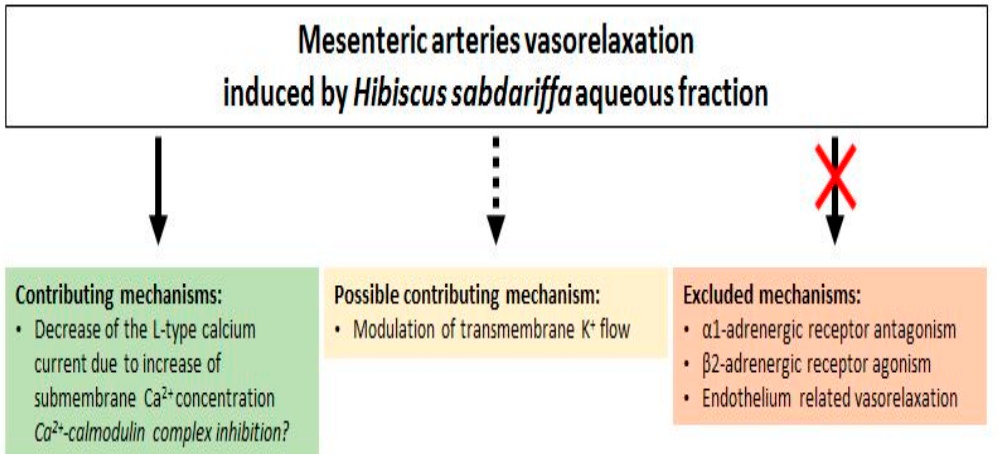
Figure 9. Diagrammatical representation of H. sabdariffa aqueous fraction mediated vasorelaxation in mesenteric arteries.